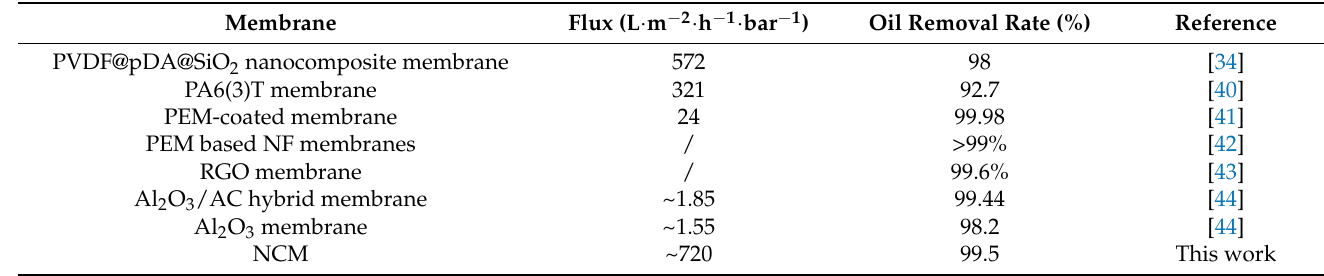
Table 1. Comparison of the separation performance among various membranes. Membrane